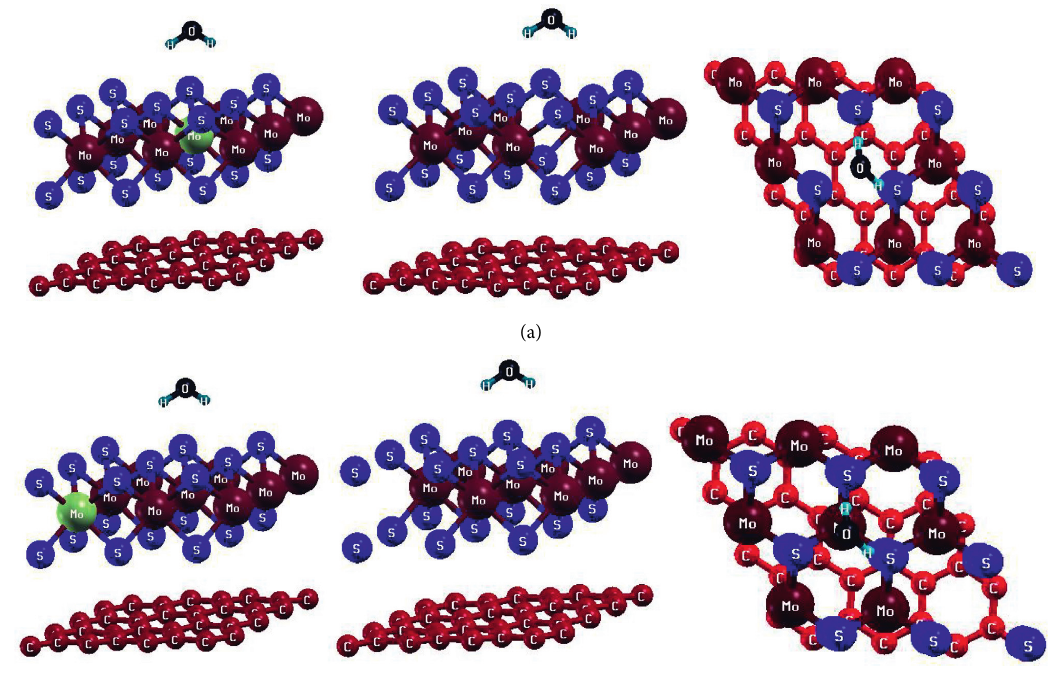
Figure 1: (a) Adsorbed water molecule is at 2.52 ˚A distance above the top surface of graphene in G/MoS (left-position) at 2.52 ˚A distance above the top surface of MoS 2 in G/MoS 2 HS. (c) adsorbed water molecule is (right-position) at 2.52 ˚A distance above the top surface of MoS 2 in G/MoS 2 HS. (d) adsorbed water molecule is (center position) at 2.52 ˚A distance above the top surface of MoS 2 in G/MoS 2